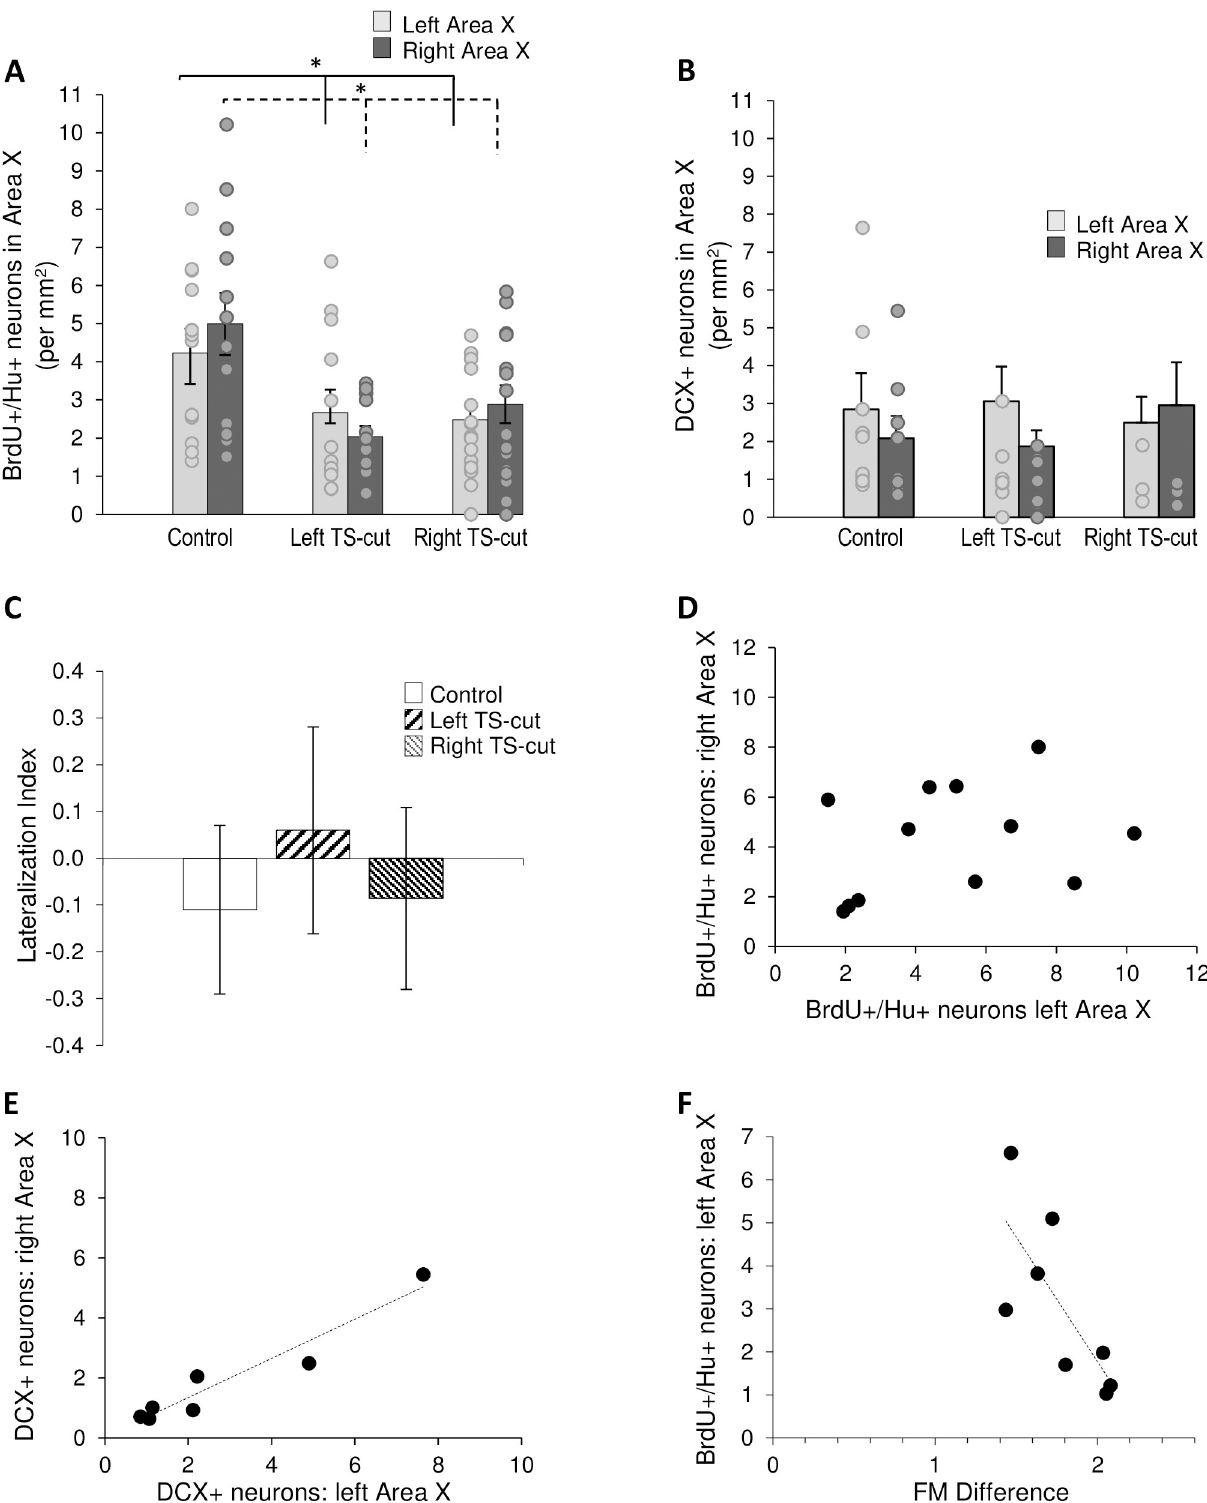
Fig 6. Numbers of new neurons in Area X as a function of hemisphere and experimental condition. A. Left (n = 12) and right (n = 14) TS-cuts significantly decreased the numbers of 28–30 day old neurons compared to controls (n = 12). Control birds had significantly more new neurons in the left hemisphere compared to the left hemispheres of the left and right TS-cut birds (solid lines). Similarly, control birds had significantly more new